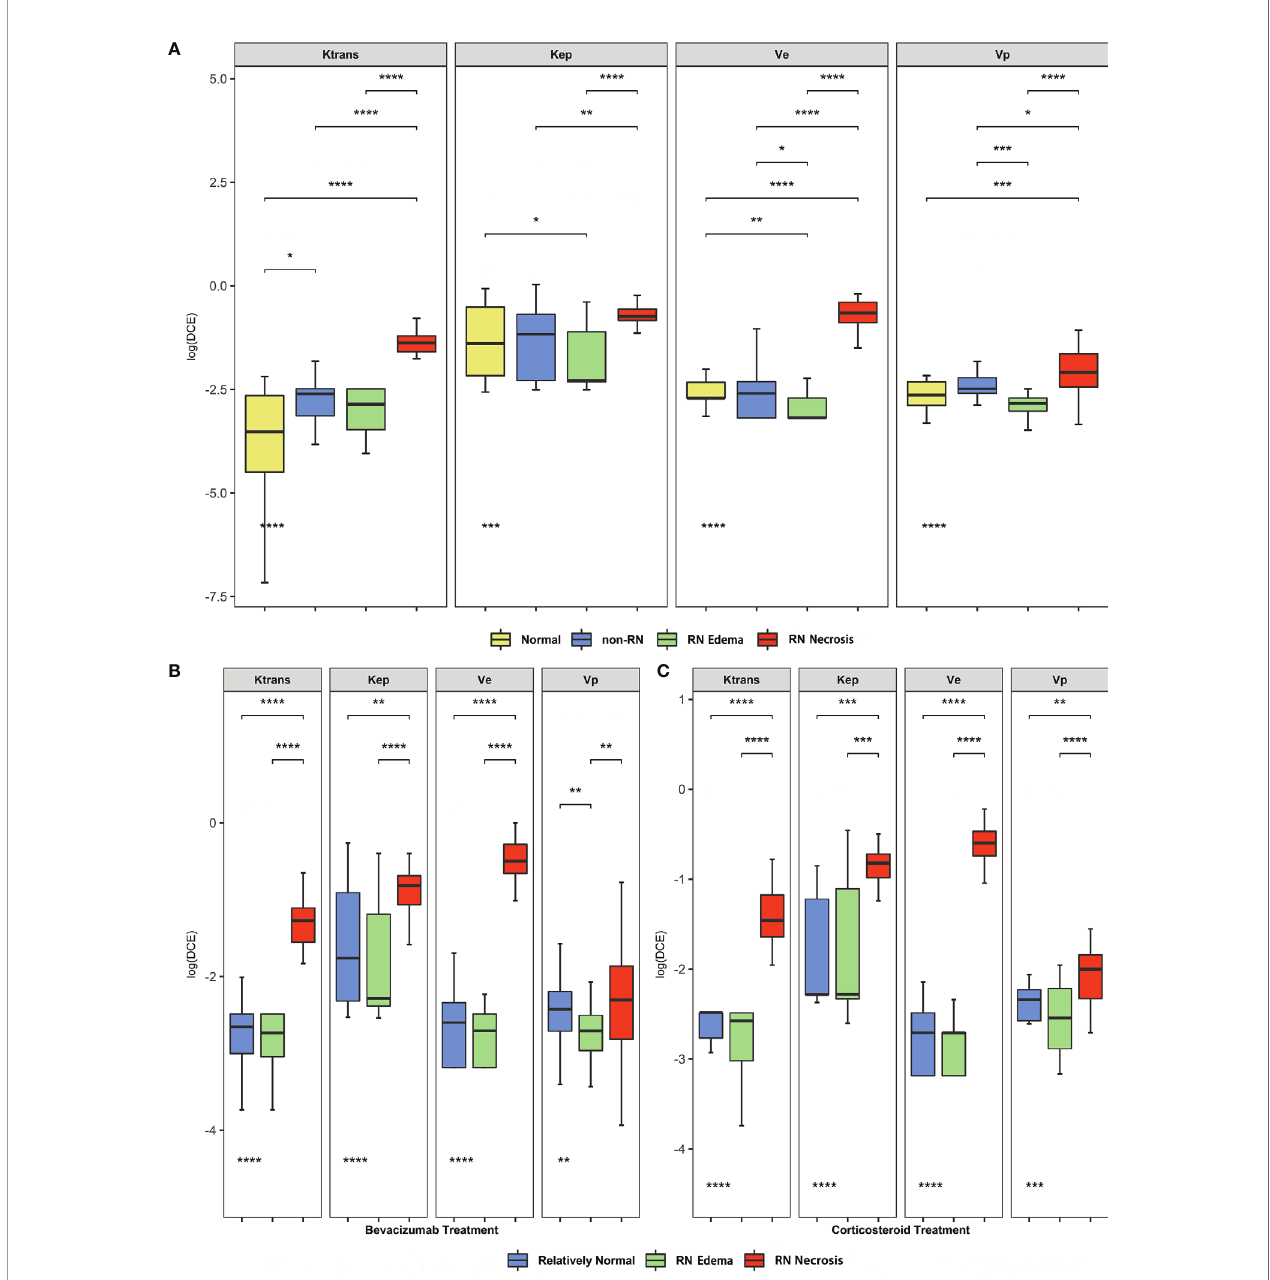
FIGURE 1 | (A) Comparison of dynamic contrast-enhanced (DCE)-derived parameters between the normal, non-RN, and normal groups. (B, C) Comparison of DCE-derived parameters among radiation-induced brain necrosis (RN) necrosis, edema lesions, and relatively normal white matter before bevacizumab and corticosteroid in the radiation injury group. The P -values marked below indicate the results of the Mann – Whitney U test. *P value < 0.05, **P value < 0.01, ***P value < 0.001, ****P value <